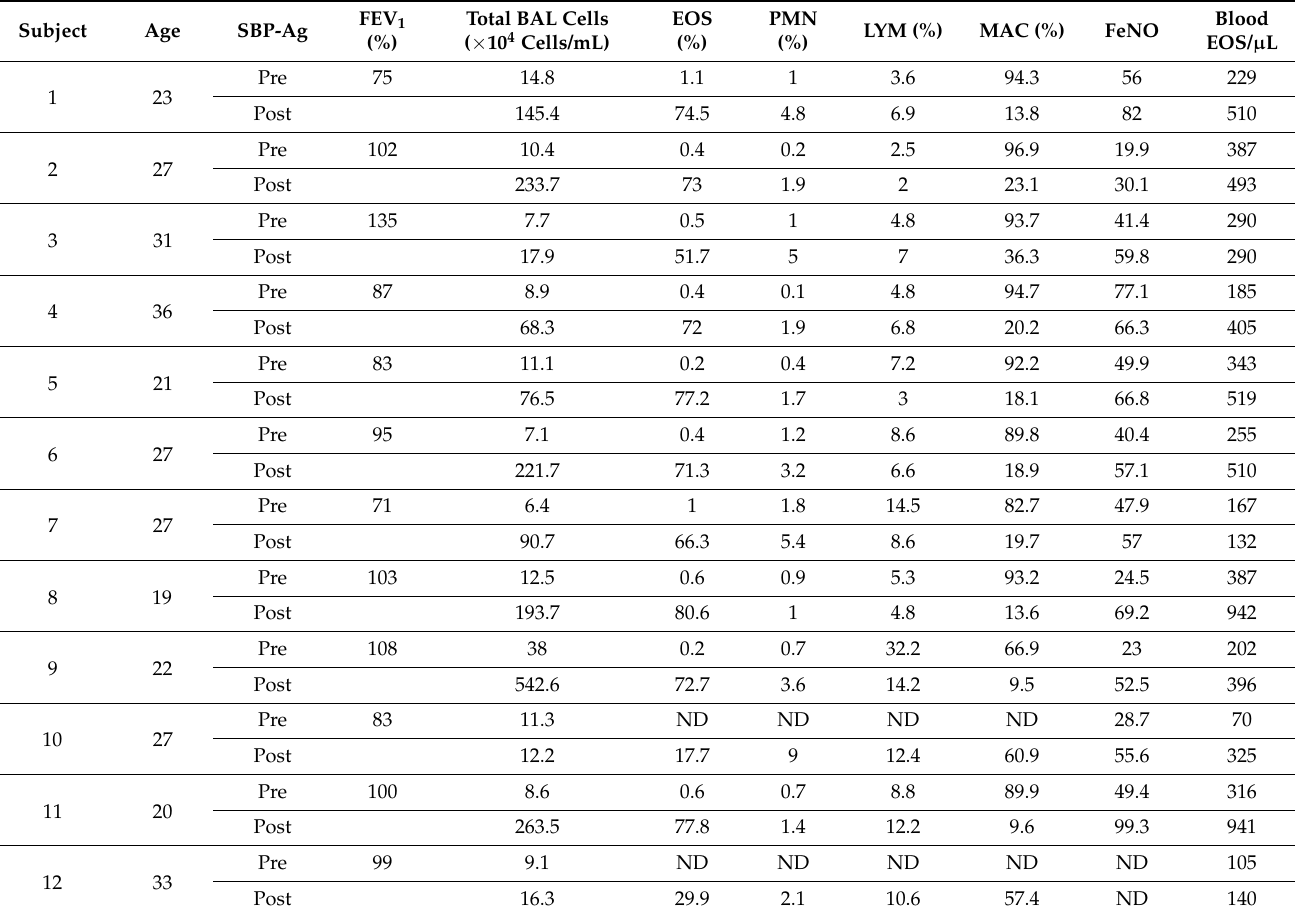
Table 1. Subjects’ demographics, n = 12 subjects.